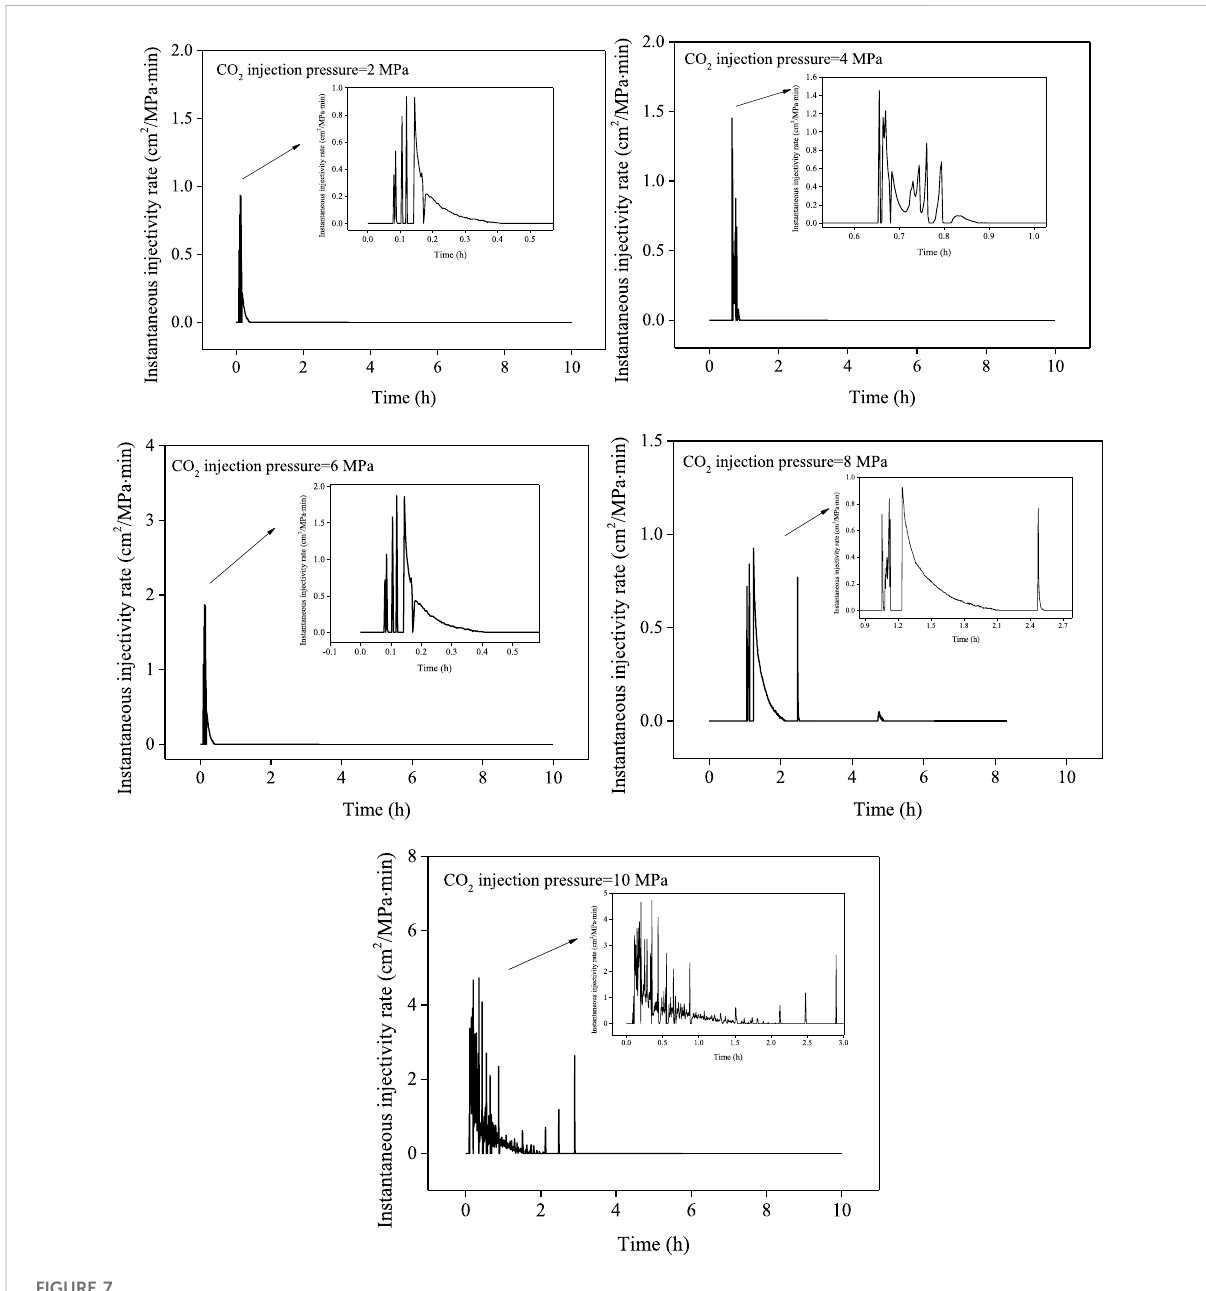
FIGURE 7 Changes in instantaneous injectivity rate with